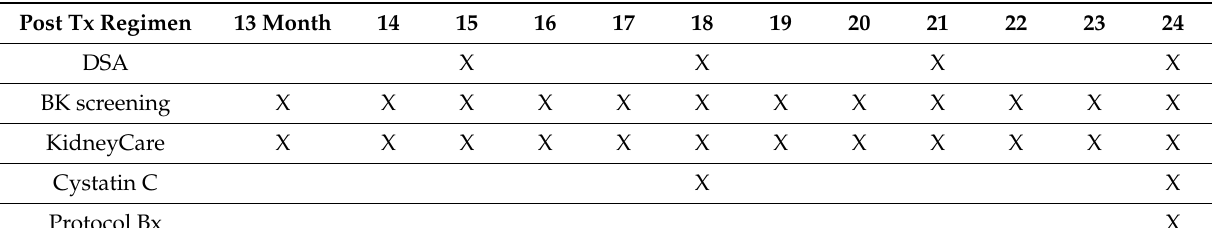
Table 2. Year Two-Continue Immunosuppressant Regimen from Month